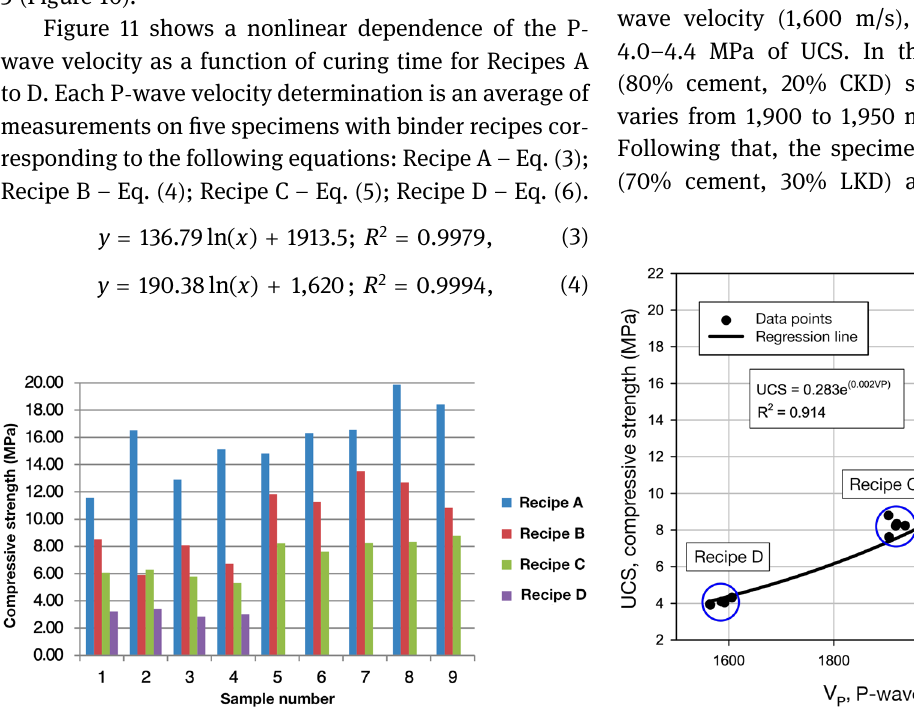
Figure 10: Compilation of the compressive strength of the various binder combinations without mixing clay.